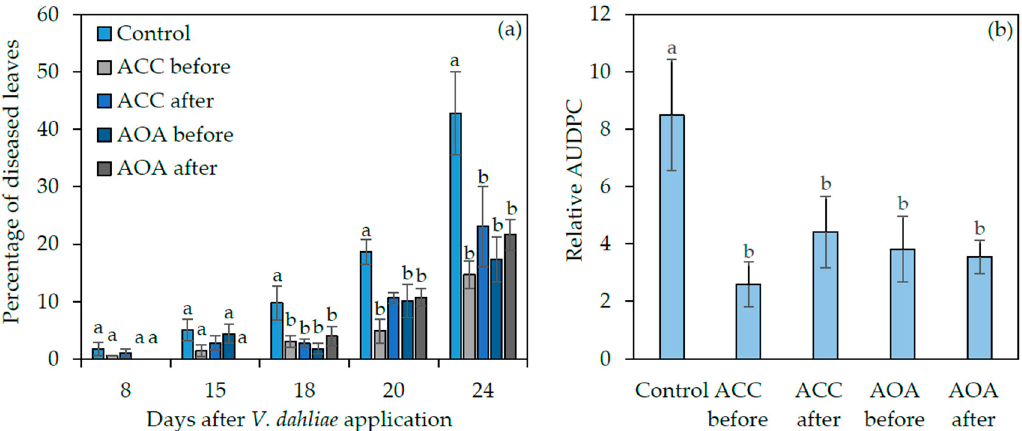
Figure 5. Disease severity ( a ) and relative AUDPC ( b ) of Arabidopsis thaliana wild type plants, root-drenched with ACC and AOA before and after inoculation with Verticillium dahliae . Vertical bars indicate the standard errors based on twelve replicates. All values were subjected to analysis of variance. At each day in ( a ) and between treatments in ( b ) di ff erent letters above columns denote statistically significant di ff erences according to LSD multiple range test at p < 0.05.